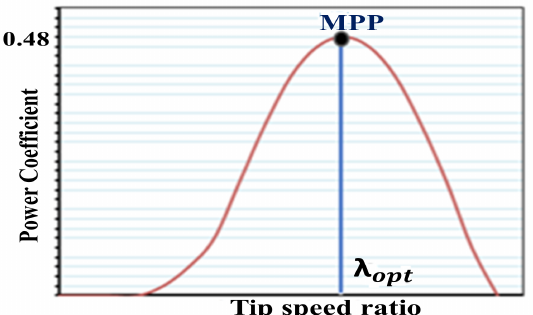
Figure 3. Relation between C p and TSR. Reused with permission from Ref. [23]. Copyright 2019 Elesevier.